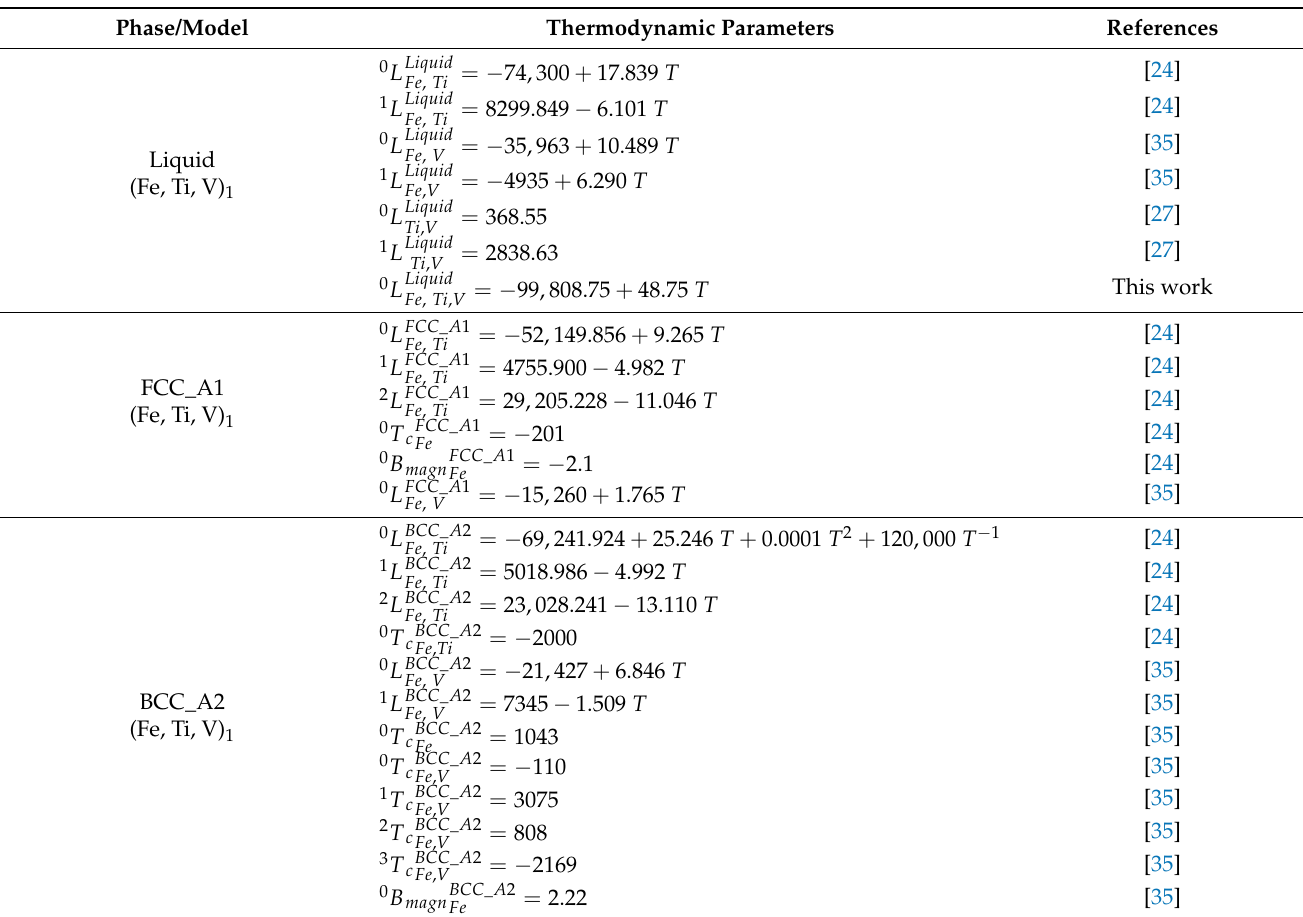
Figure 8. Calculated liquidus surface projection of the Ti-Fe-V system using the present thermody- namic description. Table 2. Summary of the thermodynamic parameters in the Ti-Fe-V system.